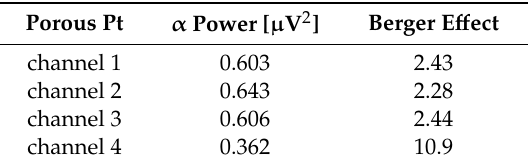
Figure 5. Averaged frequency spectra of four electrodes in the auditory canal and their standard deviation (transparent interval). The power density with closed eyes (black) is higher in the alpha band between 8 and 12 Hz than with open eyes (blue curve). This Berger e ff ect can be observed with chlorinated silver electrodes using conductive gel ( A ) that rely on state of the art technology in EEG measurements in general as well as in the new approach and dry porous platinum electrodes ( B ) that has been developed in this work. Table 2. The alpha power is calculated in the bandwidth between 8 and 12 Hz for 30 s closed eyes. The Berger e ff ect is the ratio between the alpha powers of closed and opened